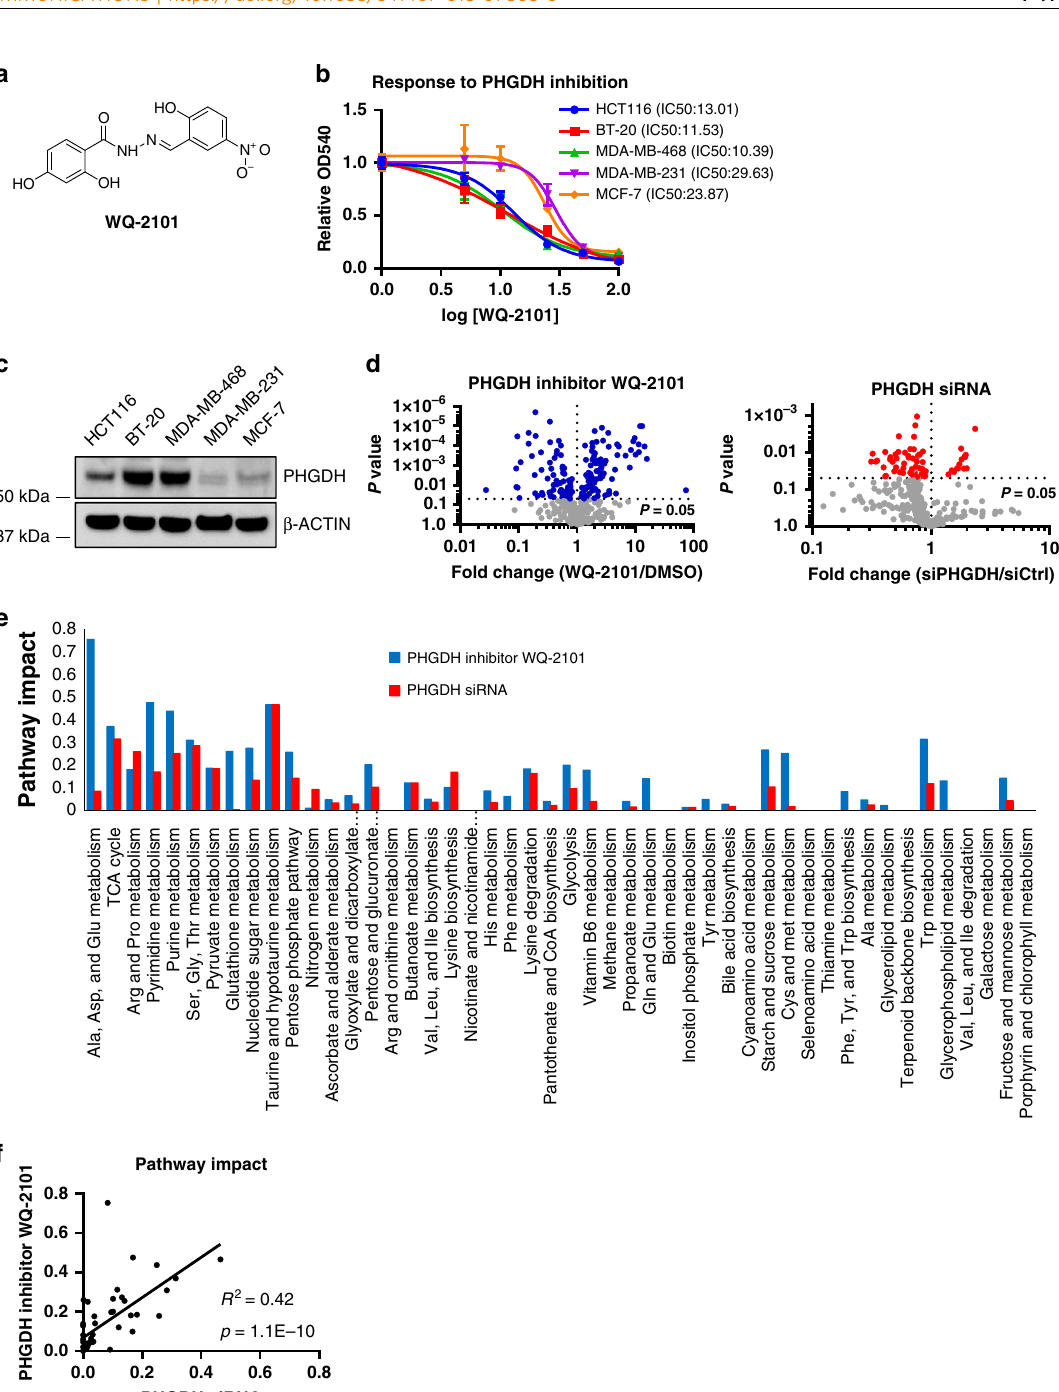
Fig. 1 Inhibition of PHGDH induces broad changes in metabolism. a Chemical structure of PHGDH inhibitor WQ-2101. b Dose-dependent response of cell lines treated with PHGDH inhibitor WQ-2101 for 72 h. Data are the mean of three biological replicates, and error bars represent s.e.m. c Immunoblot demonstrating the expression level of PHGDH in cell lines. d Volcano plots of metabolites in response to cells treated with 25 μ M PHGDH inhibitor WQ- 2101 for 24 h (left), or 20 nM siRNA targeting PHGDH 72 h post-transfection (right). Colored dots represent metabolites signi fi cantly changed between control and treated conditions ( P < 0.05). Data are mean of three biological replicates. e Network-based pathway analysis of statistically signi fi cant metabolites altered in each condition. f Scatter plot for correlation of metabolic pathway impact scores between WQ-2101 and siRNA targeting